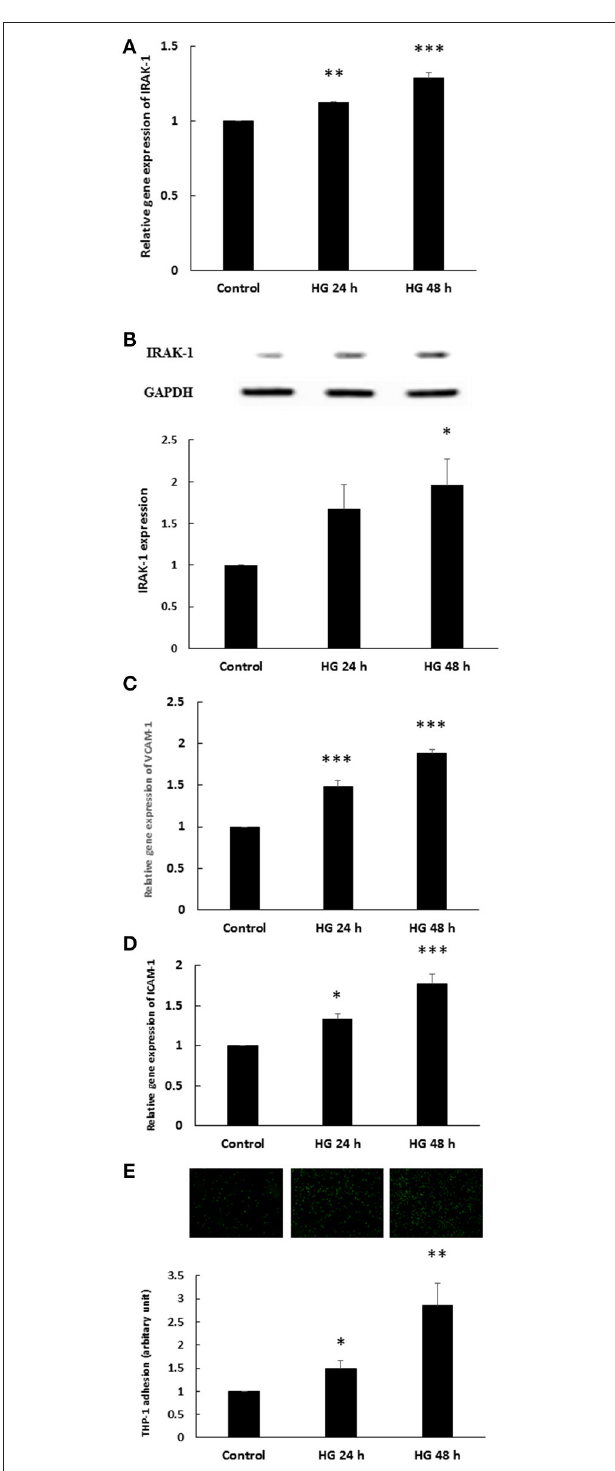
FIGURE 1 | (A–E) Endothelial IRAK-1 expression and inflammatory phenotypes were induced by high glucose (HG). (A) HAECs were stimulated with HG (25 mmol/L) for 24 and 48 h. Real-time PCR demonstrates that stimulation of HAECs with HG induced 1.12- and 1.29-fold increases in IRAK-1 mRNA levels. n = 5. ** p < 0.01 and *** p < 0.001, compared with the